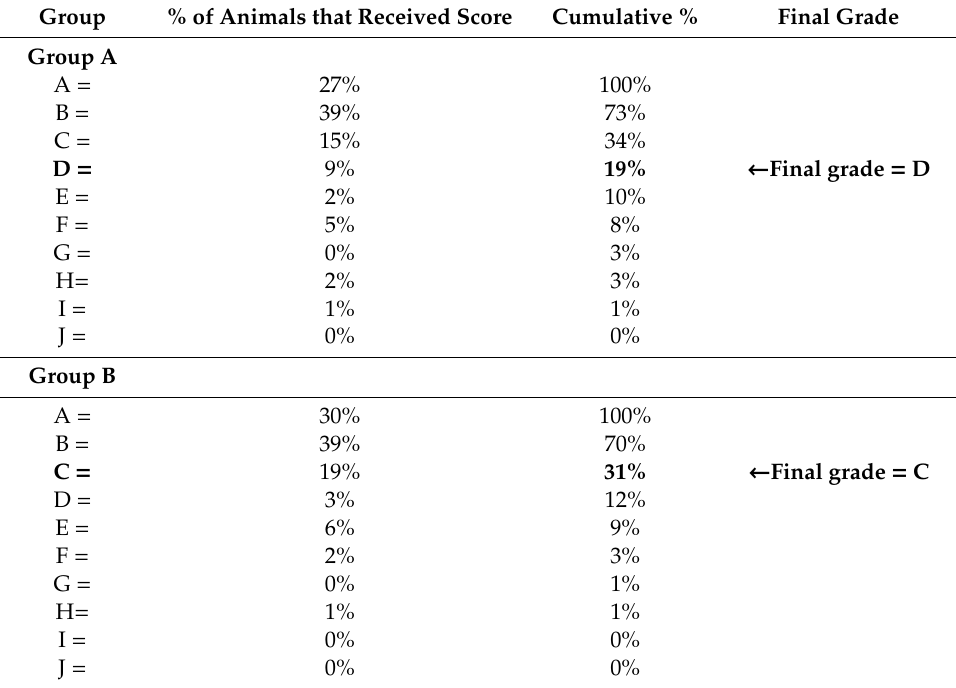
Table 2. Selection of final welfare grades for two di ff erent scenarios, using the 15% rule = [26]. The first column gives the percentage of animals within the group that received each grade after the third stage of aggregation (individual grading). The final welfare grade for the group is indicated as the first grade at which at least 15% of the individuals received that grade or a lower one, indicated by the cumulative percentage taken from worst to best